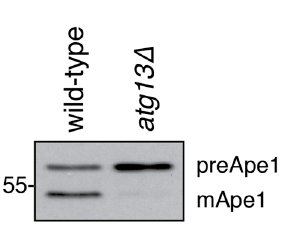
Figure 5. Ape1 processing as a readout for Cvt pathway activity. The Cvt pathway delivers the inactive precursor of Ape1 (preApe1) to the vacuole. There, preApe1 is proteolytically processed to its mature, active form (mApe1). The resulting shift in size can be detected by Western blotting using an Ape1-specific antibody. In Cvt-deficient mutants such as atg13 ∆ , Ape1 maturation is decreased or absent. Cells were grown to mid-log phase overnight. Samples were prepared by TCA precipitation.